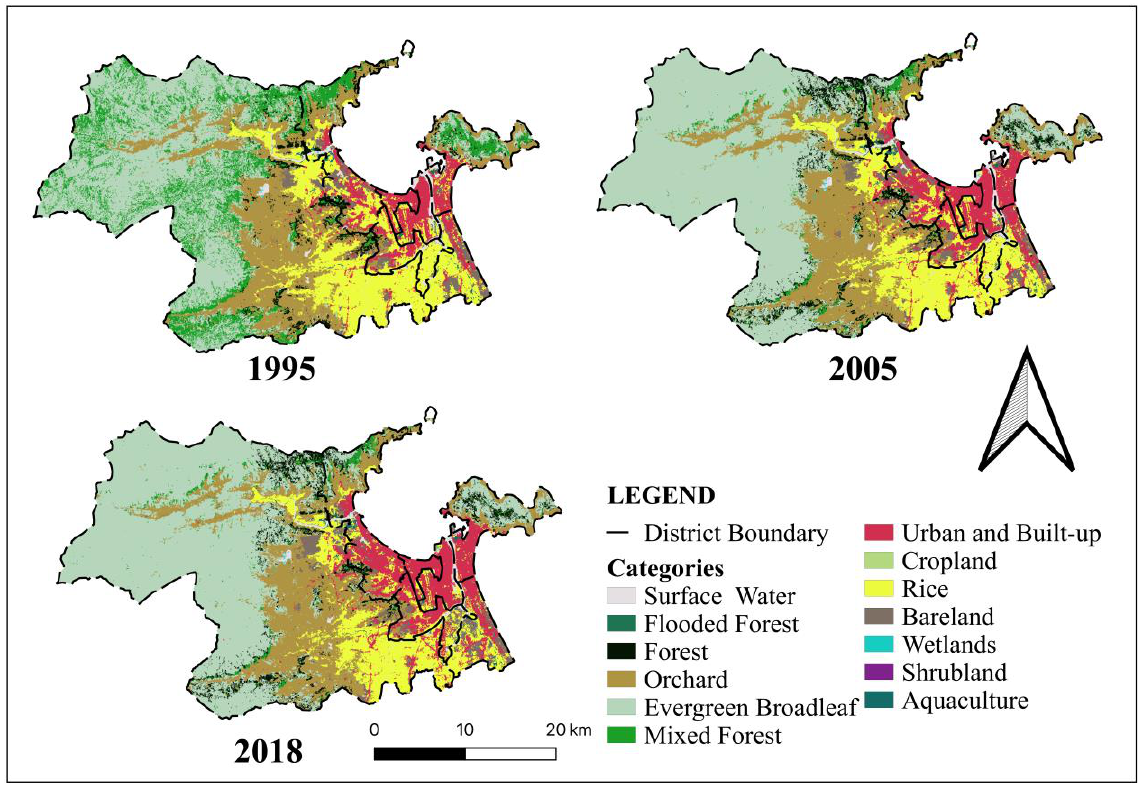
Fig. 1. Land cover in Da Nang city over the years